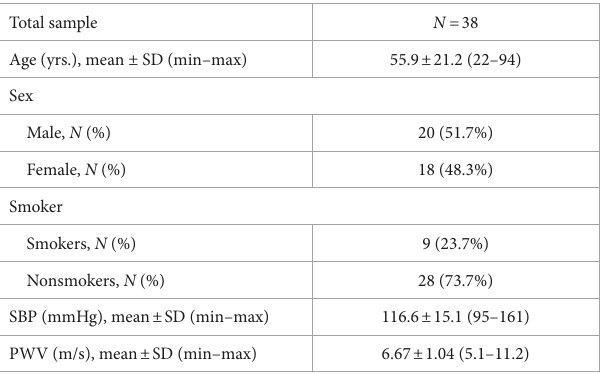
TABLE 1 Demographic characteristics of participants of the study